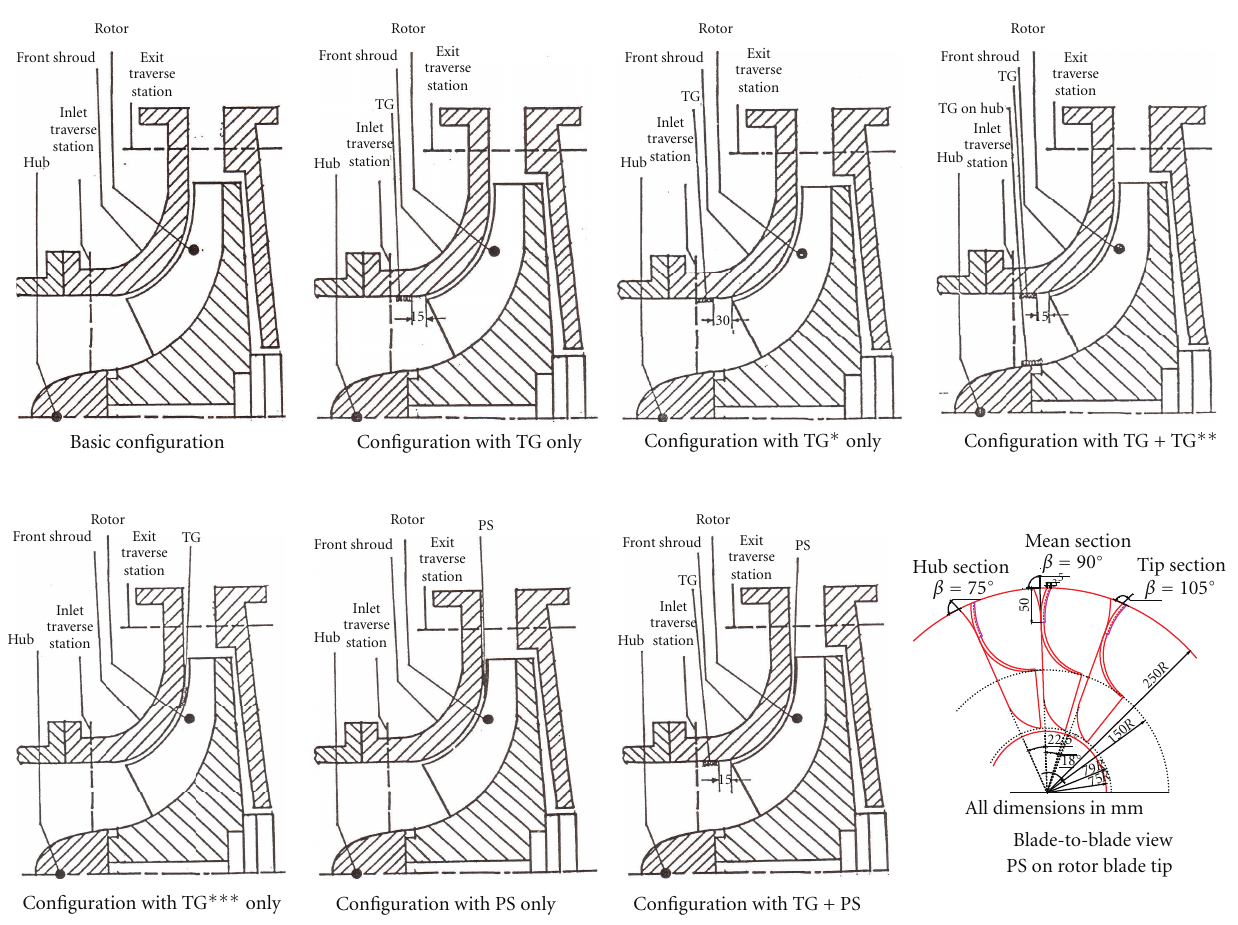
Figure 2: Details of configurations